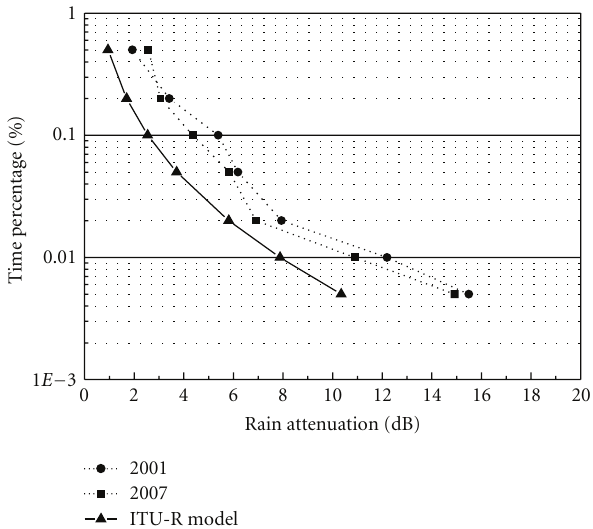
Figure 4: Predicted and measured rain attenuation cumulative dis-